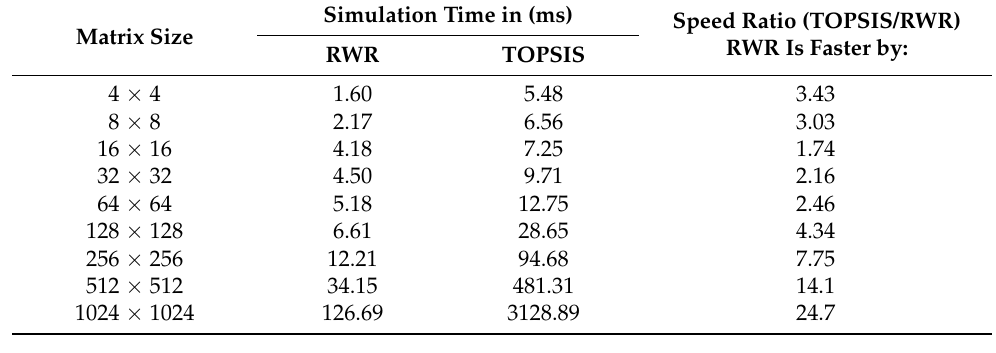
Table 7. Impact of doubling the number of alternatives and criteria on the simulation time of RWR and TOPSIS.